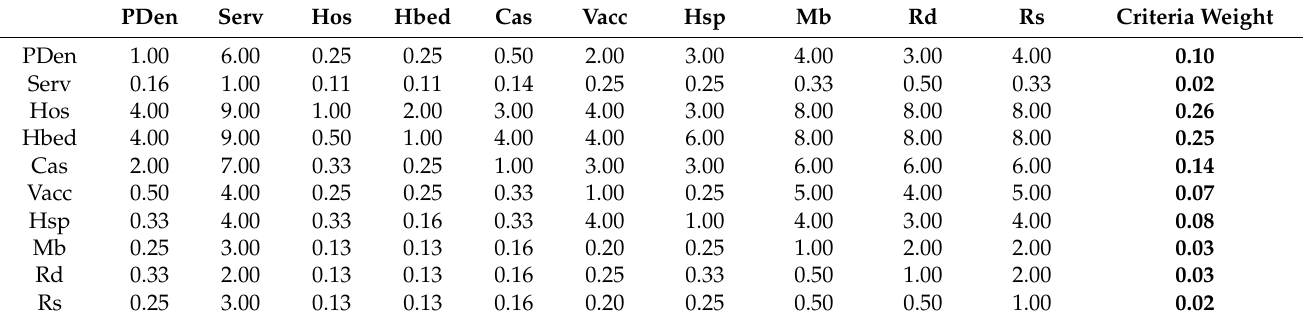
Table 3. AHP pairwise comparison matrix with calculated weights (own study based the [90]).